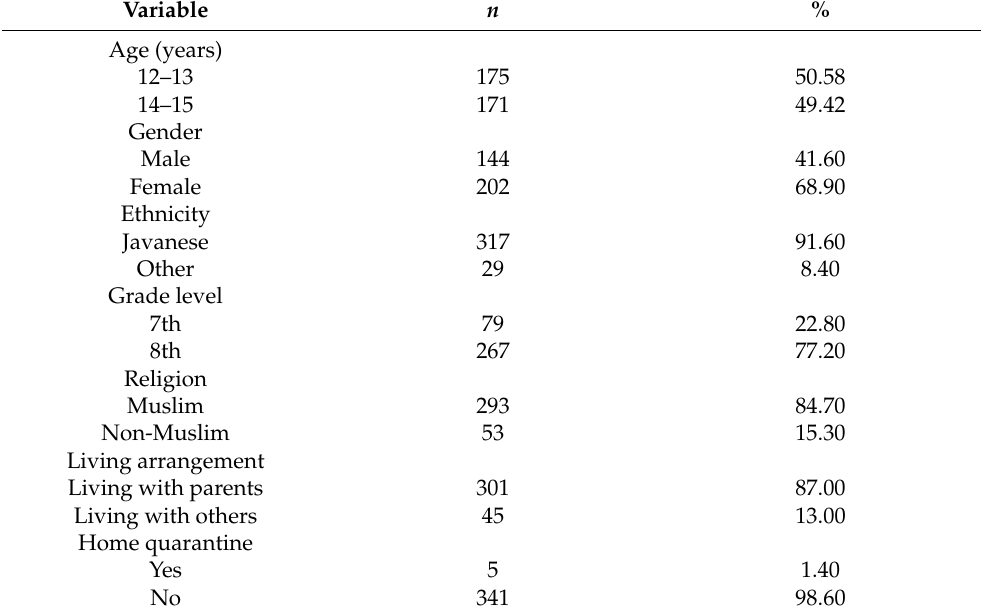
Table 1. Participant demographic characteristics ( n =